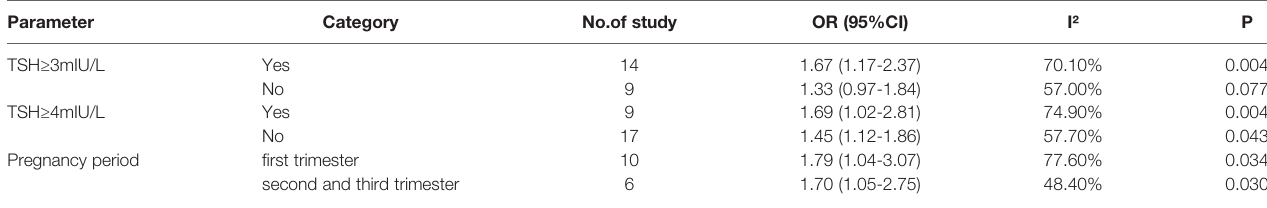
TABLE 2 | Results of subgroup